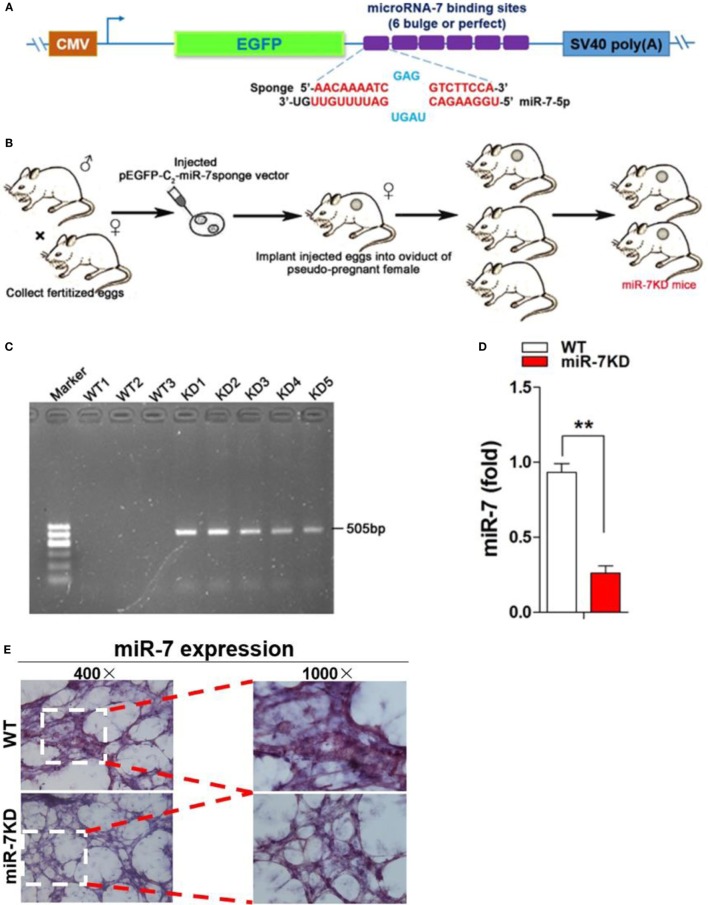
The generation of miR-7 deficiency mice. The sketch map of construction of eukaryotic expression vector encoding miR-7-Sponge (termed as p-miR-7-Sp) (A) and generation of miR-7 KD mice (B). (C) The identification of DNA. DNA was derived from wild-type (WT) or miR-7KD mice. And the expected product (505 bp size) was amplificated by PCR, respectively. (D) The relative expression of miR-7 in lung derived from WT mice and miR-7KD mice (n = 6) were detected by Real-time PCR assay. (E) The expression of miR-7 in lung tissue derived from WT mice and miR-7KD was analyzed by In situ hybridization. Representative data of three independent experiments were shown. **p < 0.01.